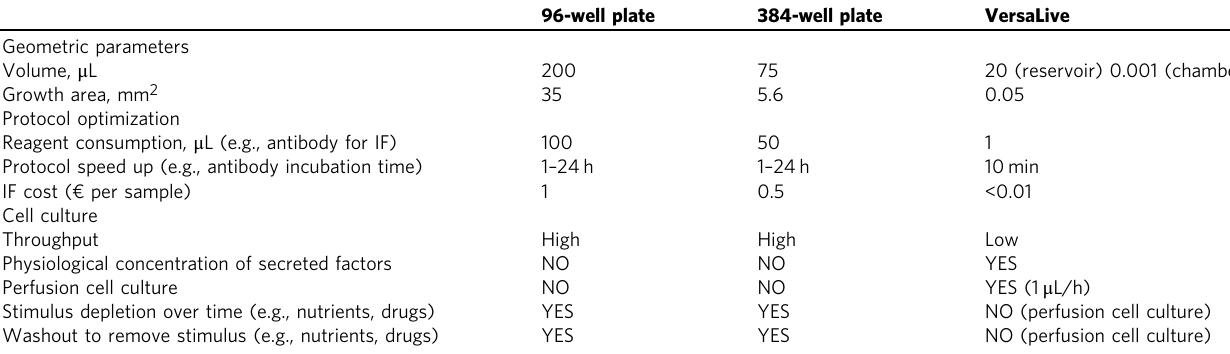
Table 1 Comparison of the main features differing between multi-well plates (96- and 384-well types) and